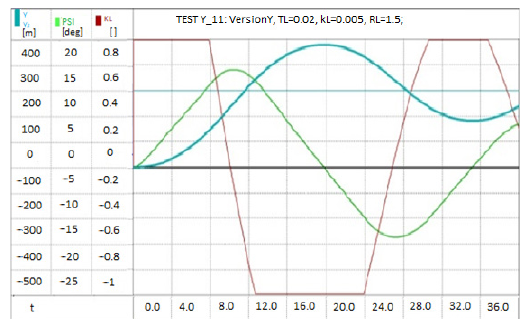
Figure 8. The transitional process of controlling flight direction Y z , with preset step changes to the coordinate Y from 0 to 300 metres. Testing the influence of the derivative constant R L with constant co-efficient of reinforcement K L = 0.005. Derivative constant of R L = 1.5